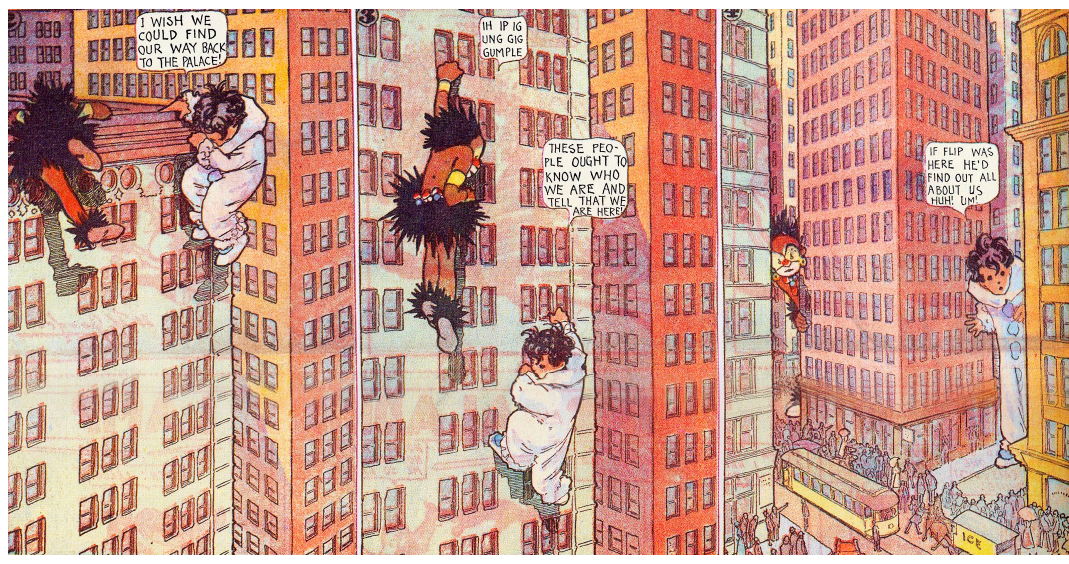
Figure 7. Winsor McCay, Little Nemo in Slumberland, 1905.